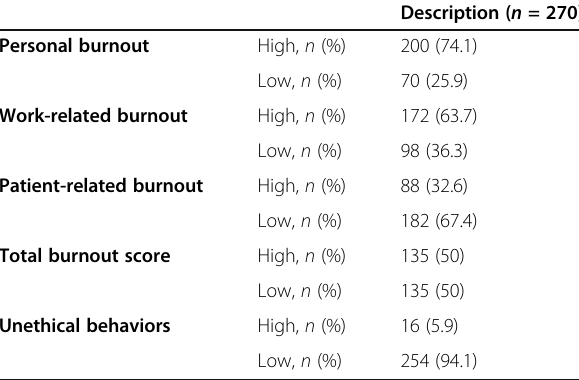
Table 2 Description of burnout and unethical behaviors ’